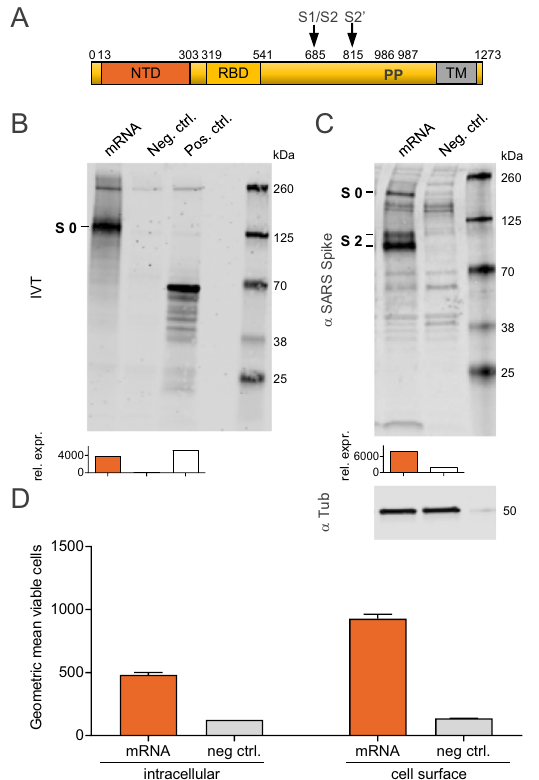
Fig. 1 Protein translated from CVnCoV is cleaved, post- translationally modi fi ed and presented on the cell surface. A Schematic drawing of SARS-CoV-2 S-2P encoded by CVnCoV. B In vitro translation of the mRNA component of CVnCoV in a rabbit reticulocyte lysate system. Translation of nascent proteins was detected via western blotting. Water and luciferase control mRNA were employed as negative and positive controls, respectively. HeLa cells were transfected with 2 µg of the mRNA component of CVnCoV. Twenty-four hours post transfection, cells were analysed for S expression via C western blotting using an S-speci fi c antibody and D fl ow cytometric analyses using an S-speci fi c antibody either with or without membrane permeabilisation allowing detection of total (intracellular) or cell-surface bound (cell surface) S protein. Relative protein expression in western blotting was quanti fi ed using the Image Studio Lite Ver 5.2 software. Geometric mean fl uorescence intensity (GMFI) of transfected HeLa cells are expressed as mean + standard deviation (SD) of duplicate samples. Blots shown in C derive from the same experiment and were processed in